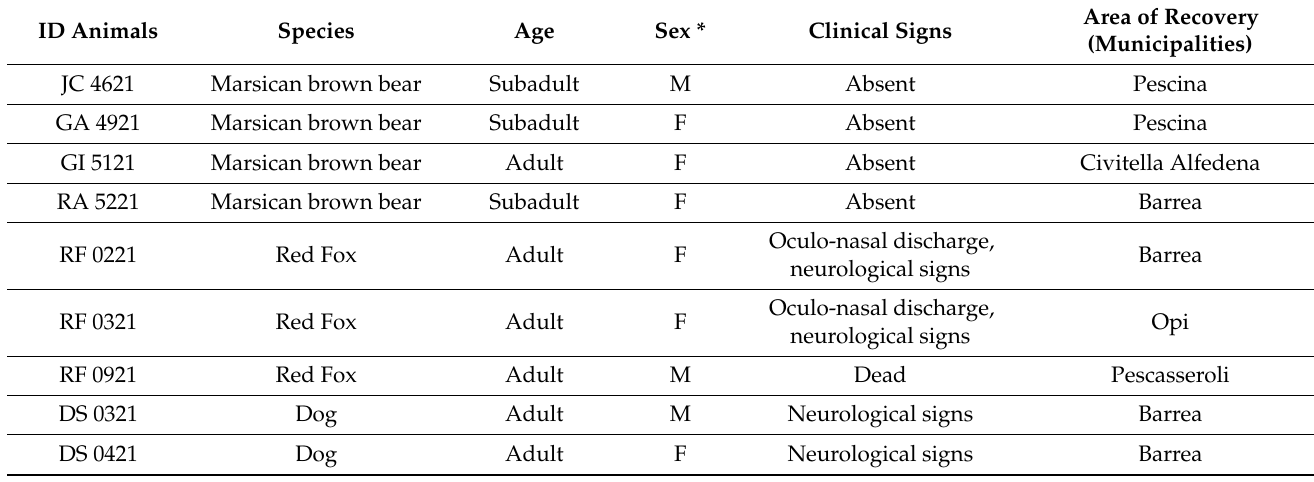
Table 1. Anamnestic data of investigated animals.